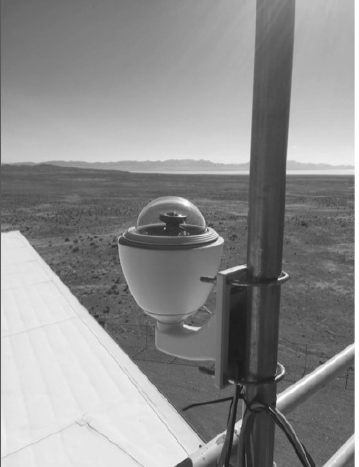
Figure 2: Overview of the Cloud Monitoring System. A camera is installed on a roof in each building to produce a good field of view of the night sky.